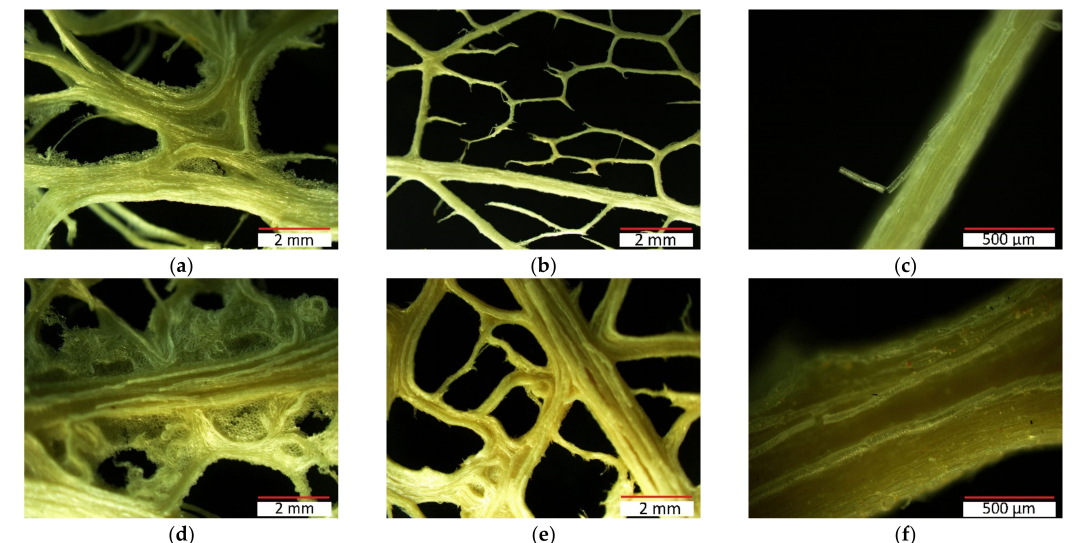
Figure 5. Optical microscope images of fibres bundles obtained by water retting process from OM young cladodes ( a – c ) and old cladodes ( d – f